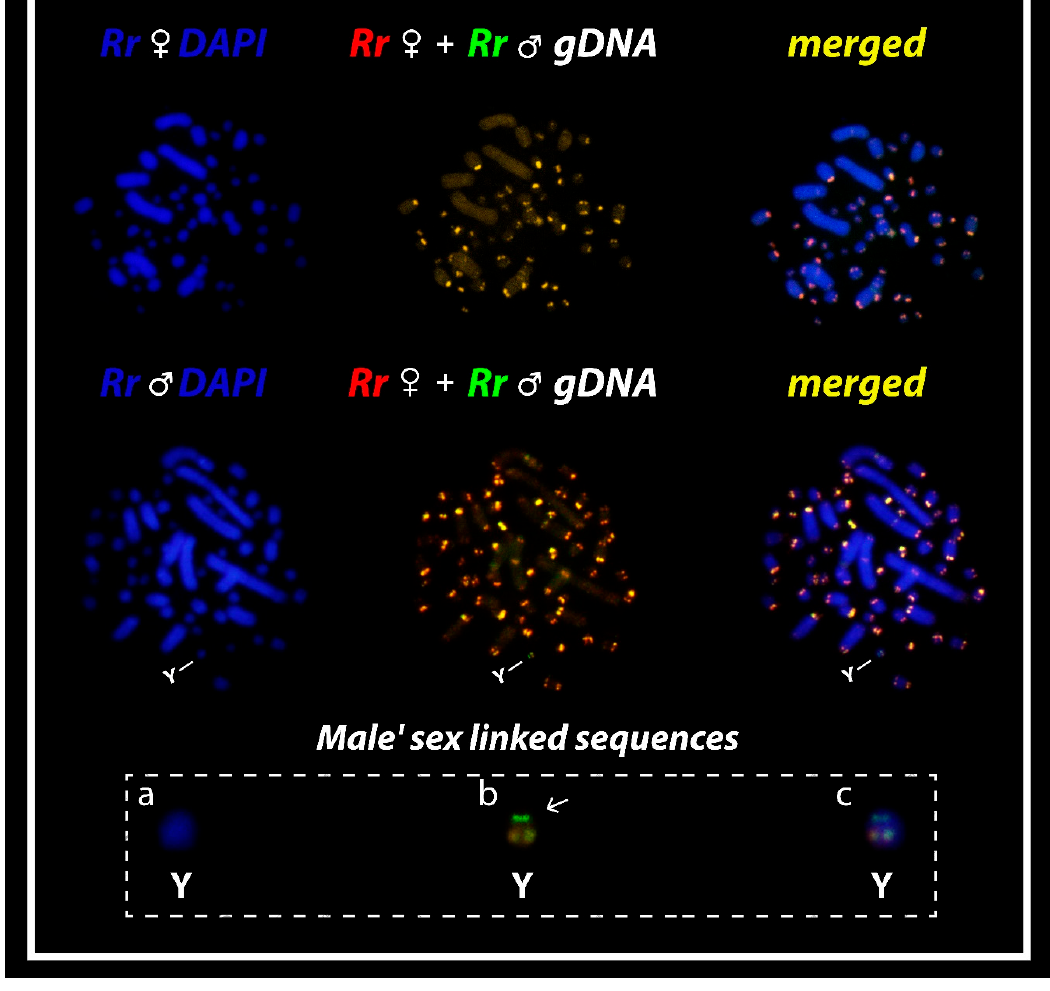
Figure 2. Mitotic chromosome spreads of R. rufipes after comparative genomic hybridization (CGH) procedures using male- and female-derived genomic probes. The common genomic regions are highlighted in yellow. The Y chromosome after DAPI ( a ), probed with male- and female-derived genomic probes ( b ) and merged image (hybridization signals + DAPI) ( c ), is highlighted in boxes. Please note the male-specific Y-linked sequences ( b ) in green.